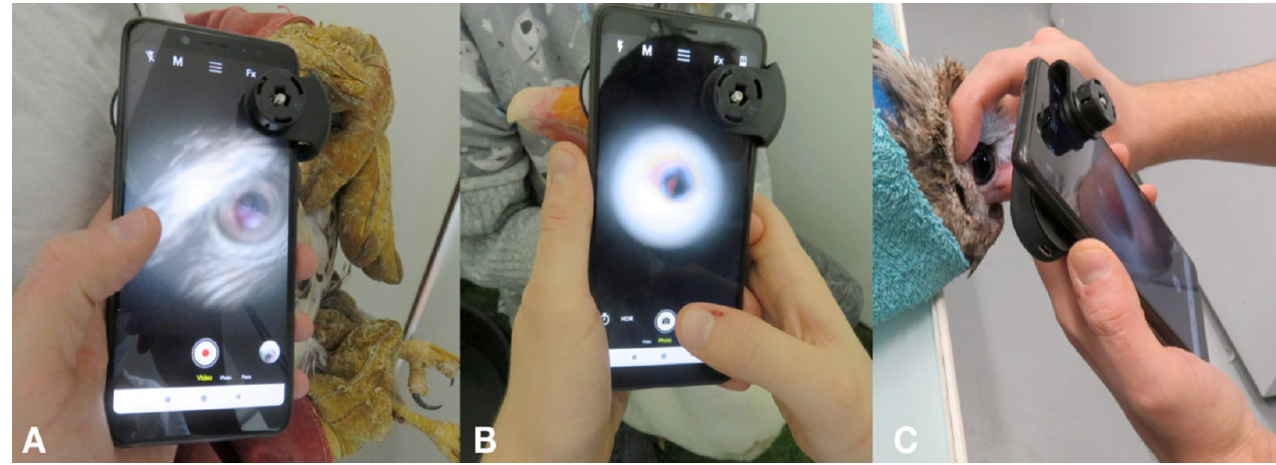
Figure 1. Fundus examination using the Peek Retina ® device of ( A ) a common buzzard ( Buteo buteo ); ( B ) a herring gull ( Larus argentatus ); ( C ) a tawny owl ( Strix aluco ) (Supplementary Video S1).